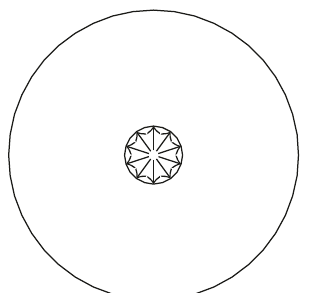
Figure 12: Calculation model of the stress